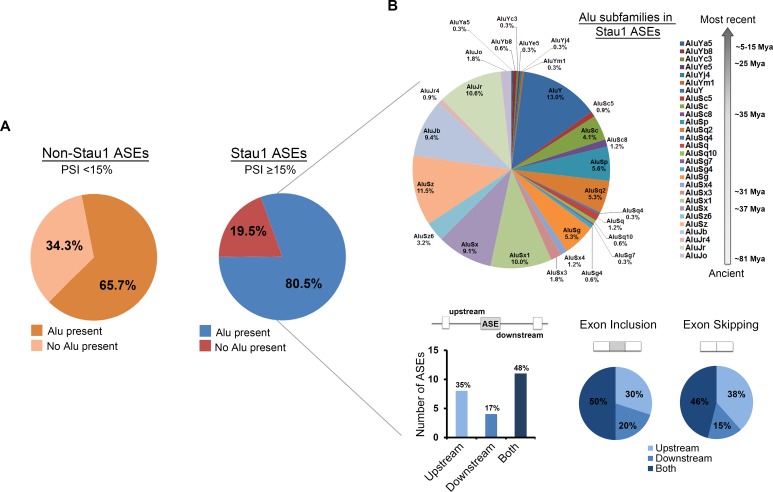
Alu elements in Stau1 and non-Stau1 regulated ASEs.(A) All ASEs were considered for this analysis with the exception of any that had a blank PSI, as described above. Stau1 (≥15% PSI) and non-Stau1 regulated ASEs targets were searched using RepeatMasker software v 4.0.5, to identify the presence of Alu elements in introns flanking the ASE. (B) The subfamilies of Alu elements in Stau1-regulated targets are presented. The locations of Alu elements in Stau1-regulated cassette-type ASE containing targets are represented in a bar graph as the number of Alu elements found in the upstream, downstream or in both introns surrounding the ASE. The locations of these intronic Alu elements were then correlated to the type of splicing event induced by Stau1 overexpression, i.e. exon inclusion or exon skipping.